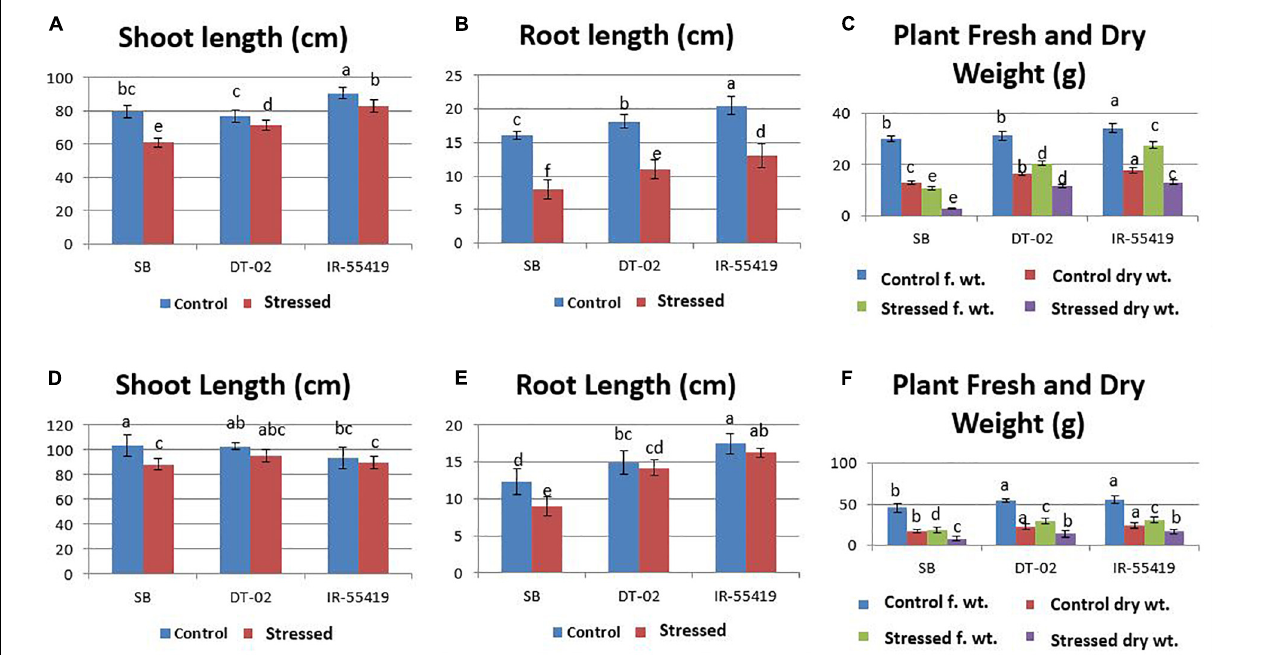
FIGURE 5 | Effect of water stress on rice growth parameters under net house conditions. (A) Shoot length (cm). (B) Root length (cm). (C) Plant fresh and dry weight under control-fully irrigated and stressed-water with holding for 15 days at 30 days after transplantation (DAT). (D) Shoot length (cm). (E) Root length (cm). (F) Plant fresh and dry weight under control-fully irrigated and stressed-water with holding for 15 days at 60 DAT. Rice genotypes: SB, IR-55419, and DT-02. Bars indicate the SD of three biological replicates and each replicate has three plants. Data represented as means and means followed by the same letter differ non-significantly and with different letters show statistical significance at p = 0.05 according to LSD.